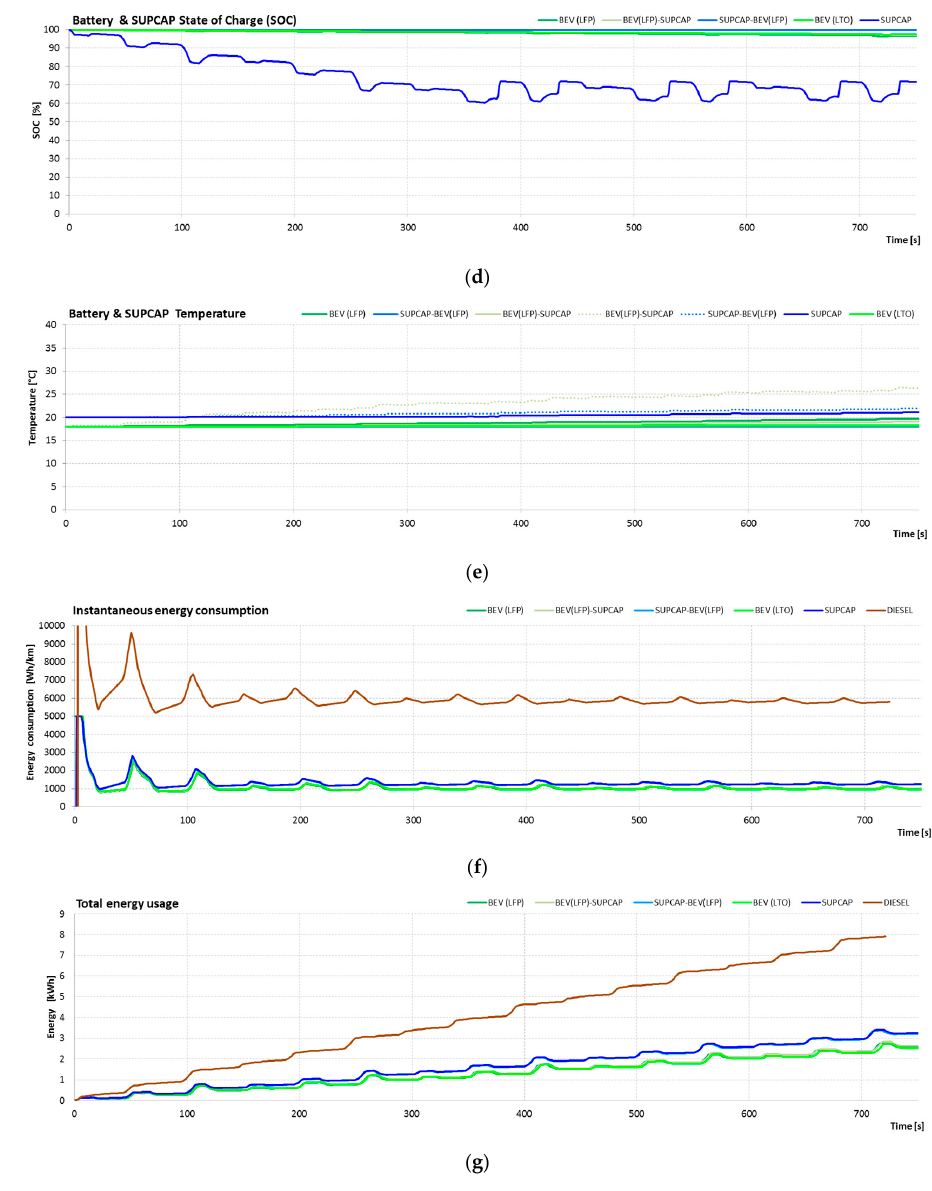
Figure 9. SORT 1 results of simulation tests, where: ( a ) Bus speed during tests (km/h); ( b ) Voltage and Current on DC-link (V), (A); ( c ) Motor/Engine Power (kW); ( d ) Battery & SUPCAP State of Charge (%); ( e ) Battery & SUPCAP temperature (°C); ( f ) Instantaneous energy consumption (Wh/km); ( g ) Total energy usage (kWh).